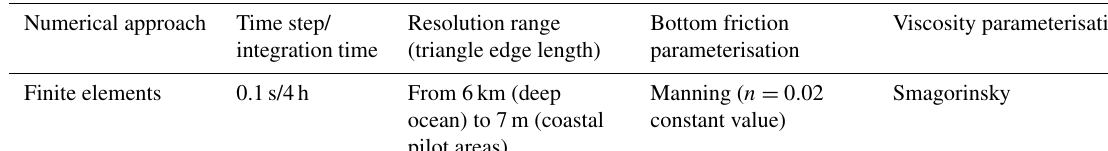
Table 1. Summary of TsunAWI model parameters used in the tsunami simulations.